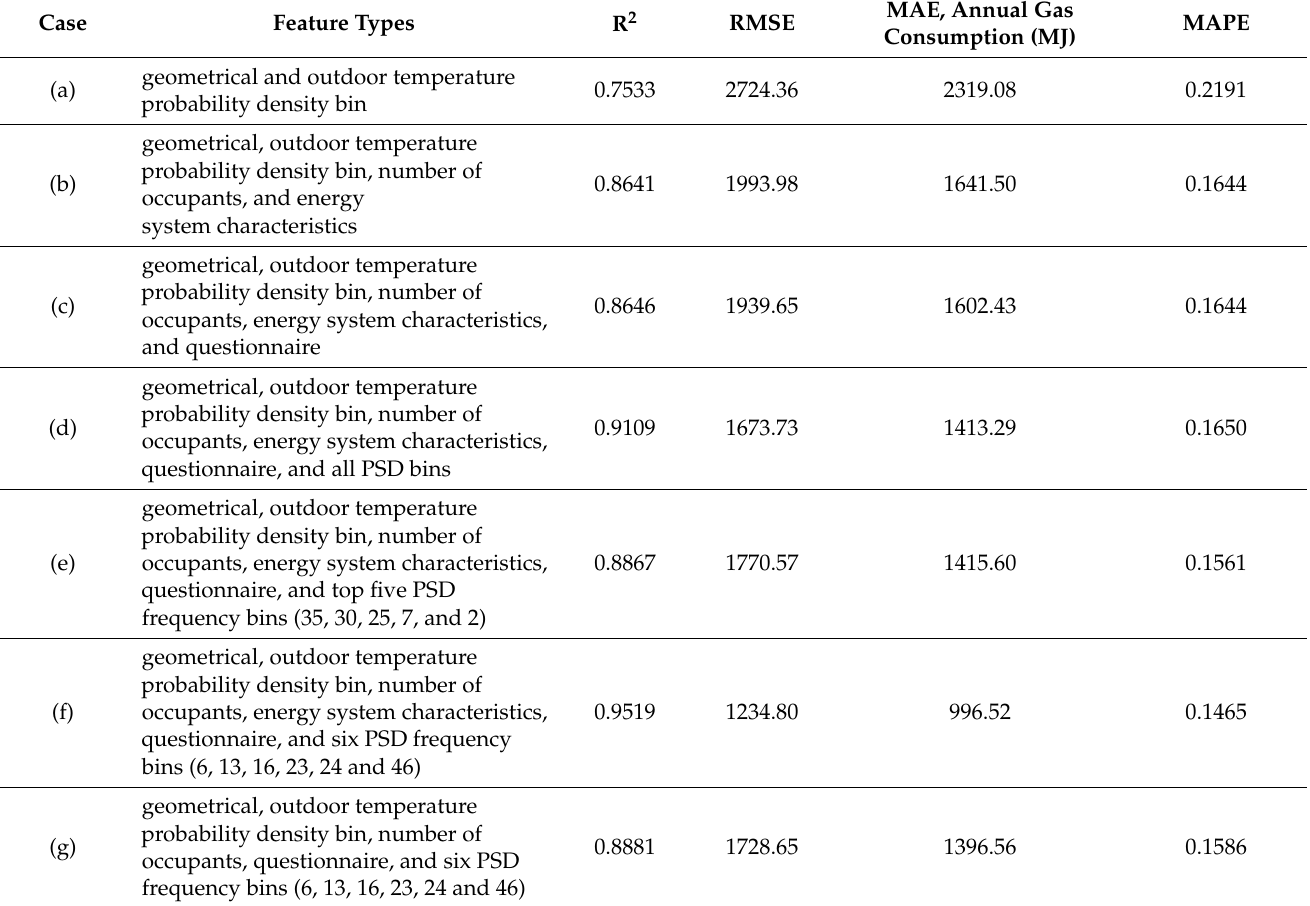
Table 5. Feature selection cases with model prediction evaluation parameters for the testing